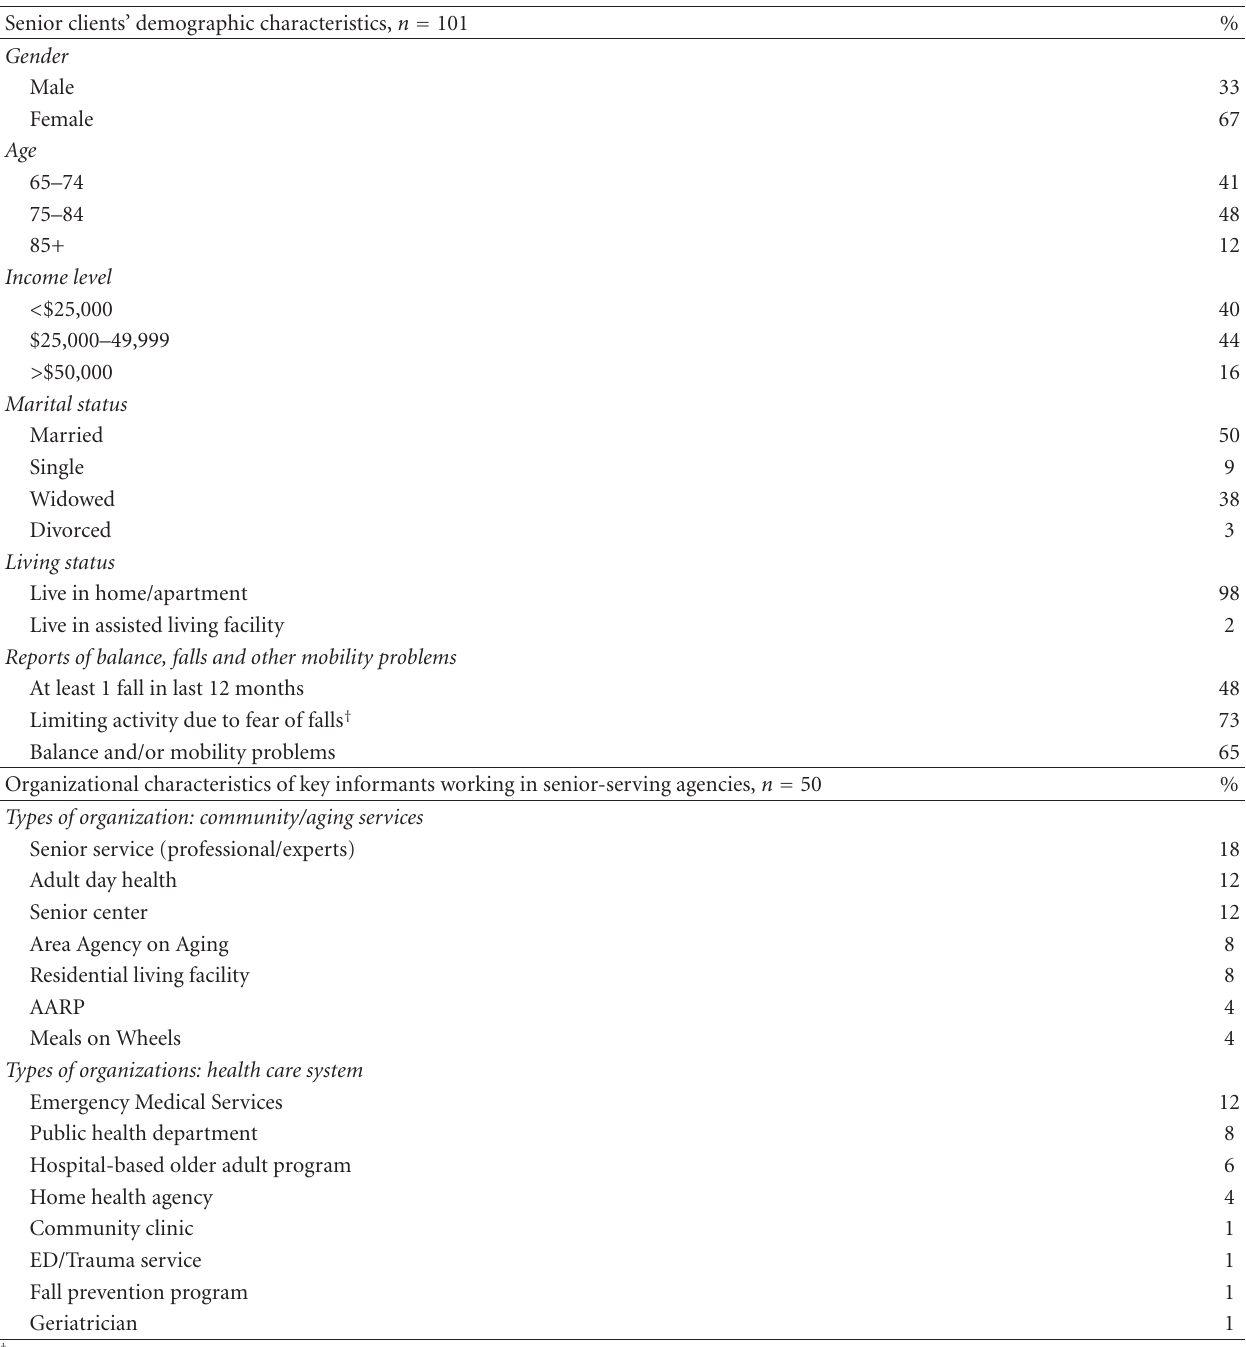
Table 1: Demographic characteristics of older Adults and organizational characteristics of senior-serving employees in Washington State,